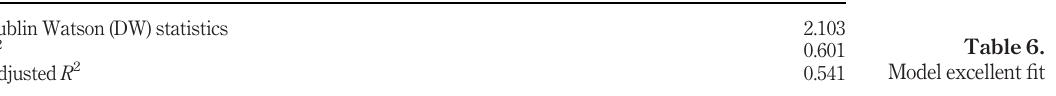
Table 6. Model excellent fi